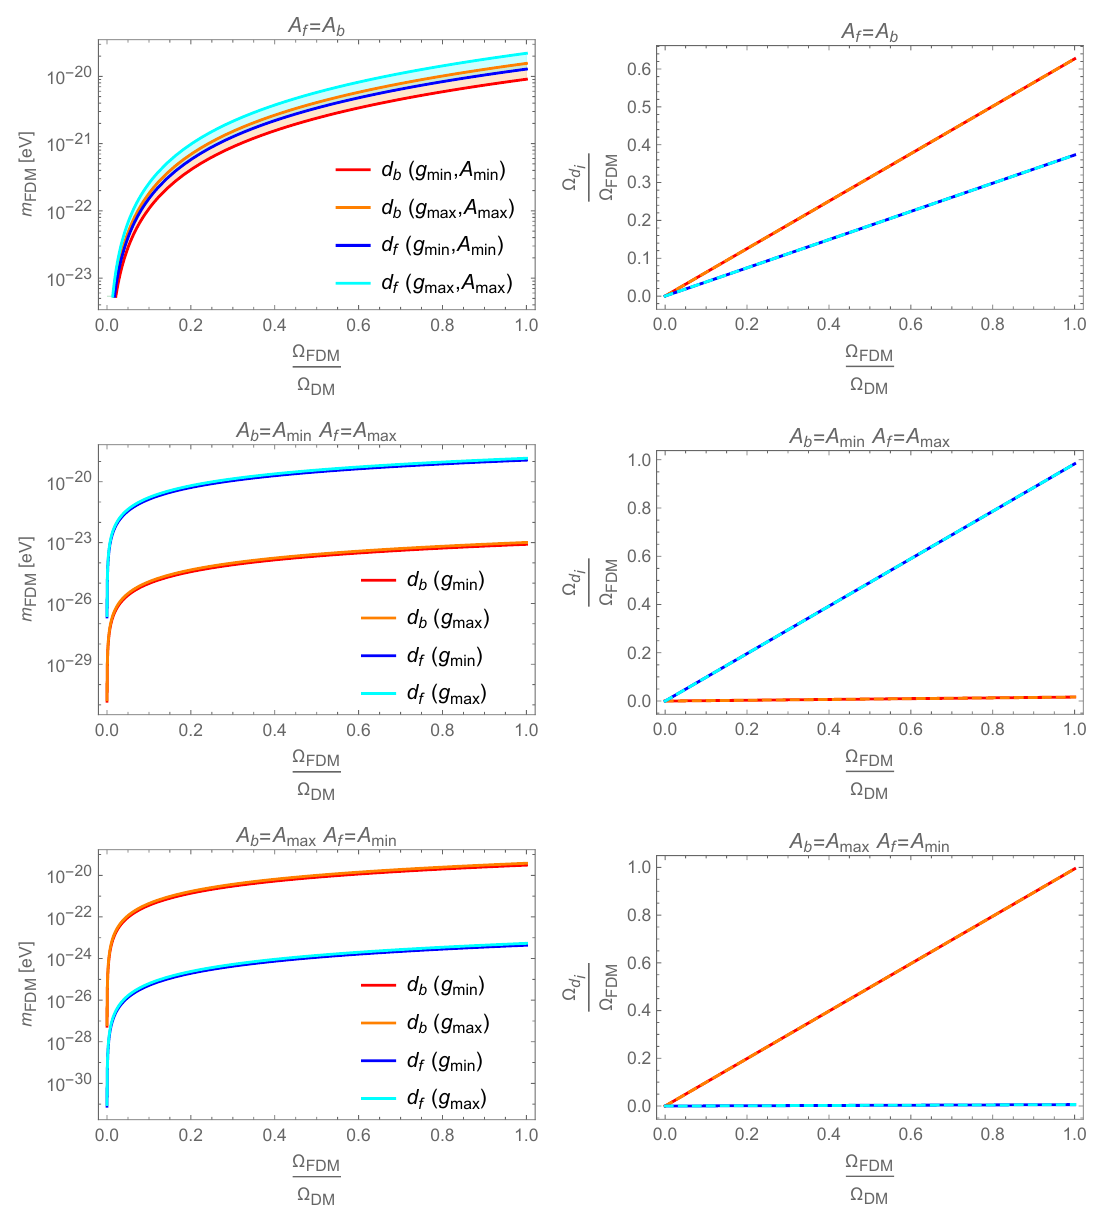
Figure 4 . Left: d f and d b axion masses as a function of the total ultralight axion fraction of dark matter. Right: relative contributions to Ω are referred to equal values of the perturbative corrections prefactors A bottom panels contain the results related to the cases where A A f = A min (cid:28) A b = A max respectively. The extreme values A min and A max can be read from table